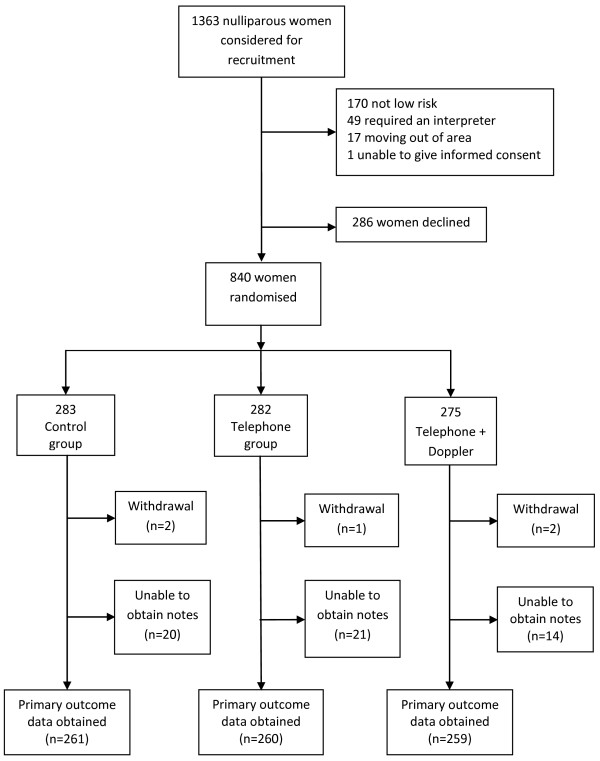
Trial flow chart.